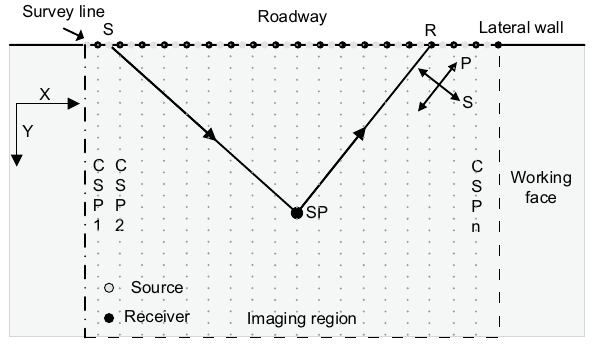
Fig. 2 Observational arrangement for seismic scattered wave detec- tion in the working